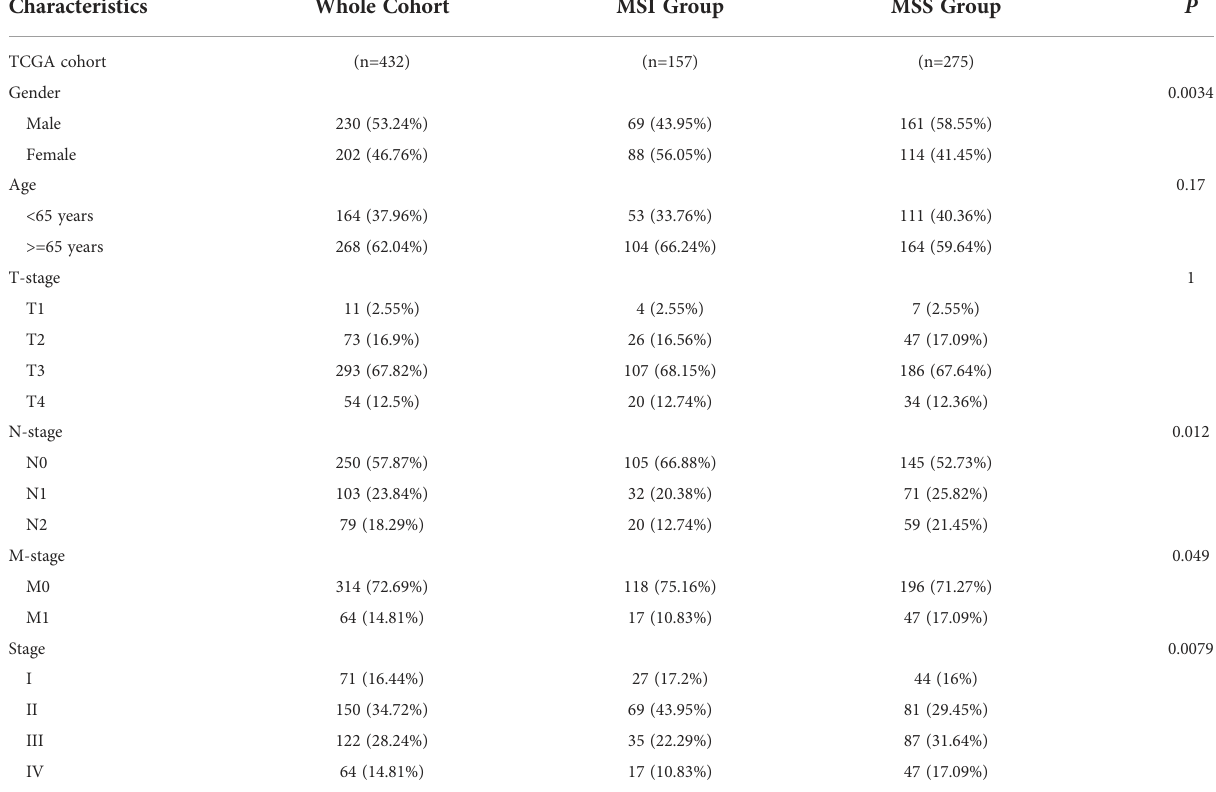
TABLE 1 Baseline characteristics of patients in TCGA COAD